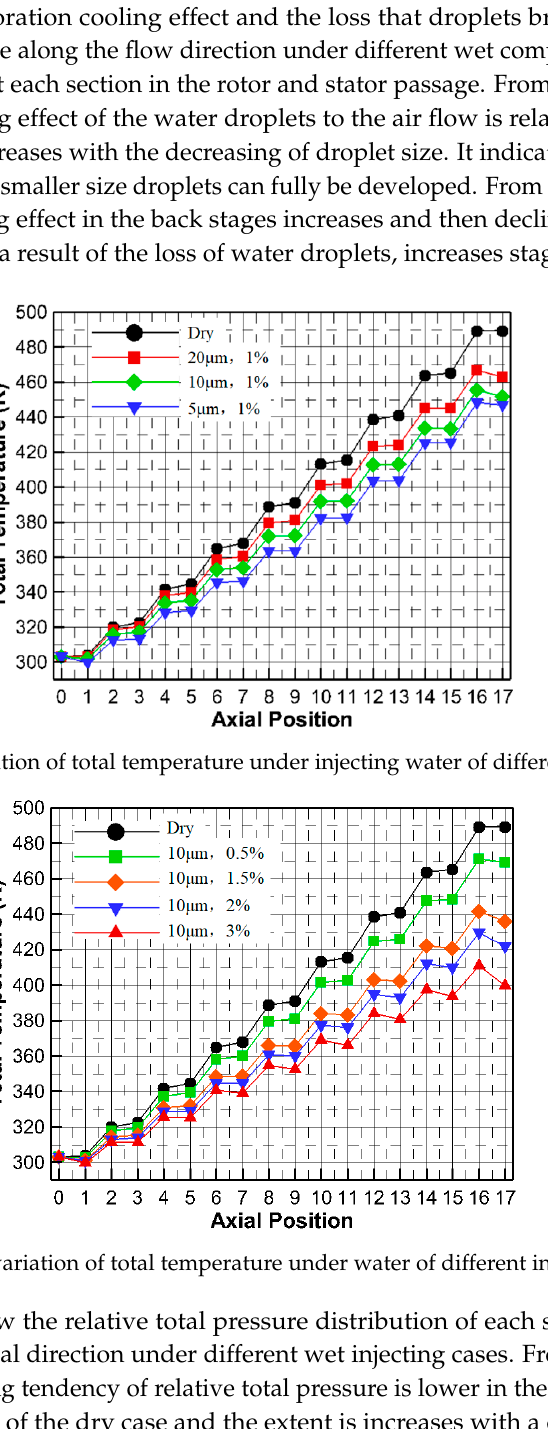
Figure 27. Axial variation of relative total pressure under injecting water of different droplet sizes.